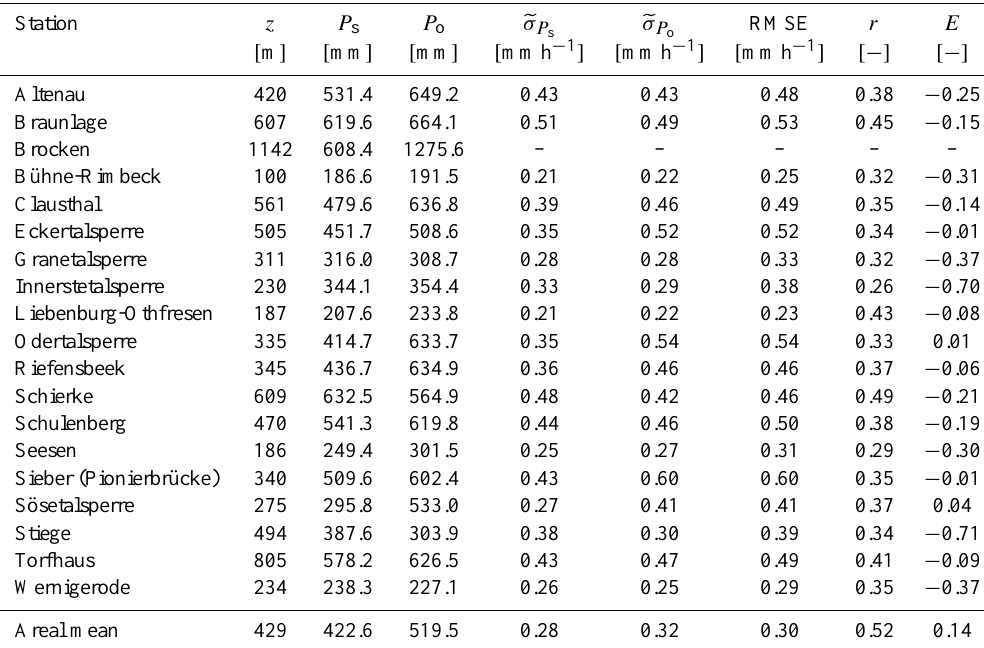
Table 5. Comparison of observed and simulated precipitation time series for each station. This table includes the elevation of each station ( z ), simulated and observed precipitation depth for the winter season 2005–2006 ( P s and P o ), the corresponding standard deviation of simulated and observed precipitation intensity ( e σ P and e σ P ), correlation between simulated and observed precipitation ( r ), root mean square error s o (RMSE), and the model efficiency ( E ). The temporal resolution of this evaluation is (cid:49)t = 1h, which is available for 18 of 19 stations (performance measures for the Brocken are excluded since the temporal resolution of these station recordings is (cid:49)t = 6h). Observed values are not corrected for this comparison.